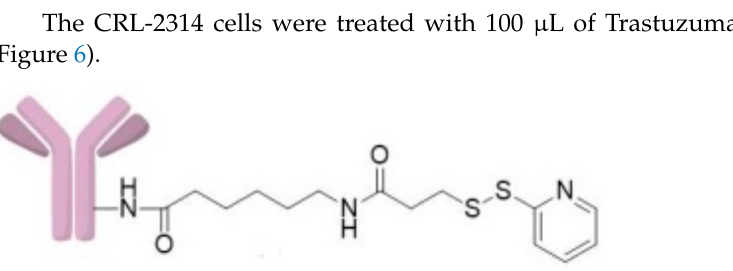
Figure 6. PAMAM G5-Sulfo- LC-SPDP ( 4 ).